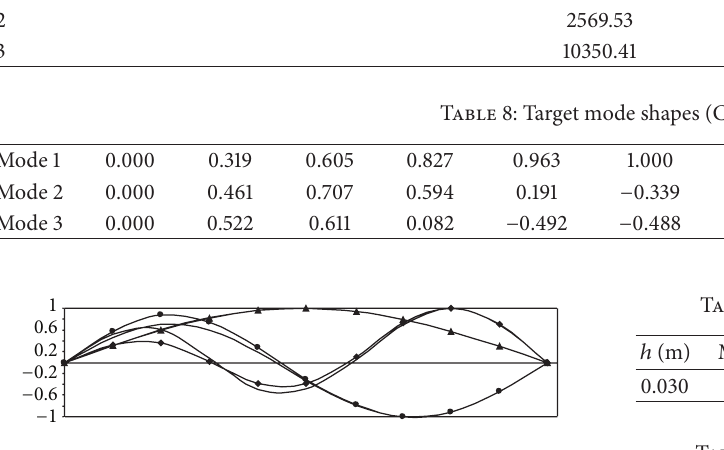
Figure 4: Optimal and target mode shapes (Case 2A).